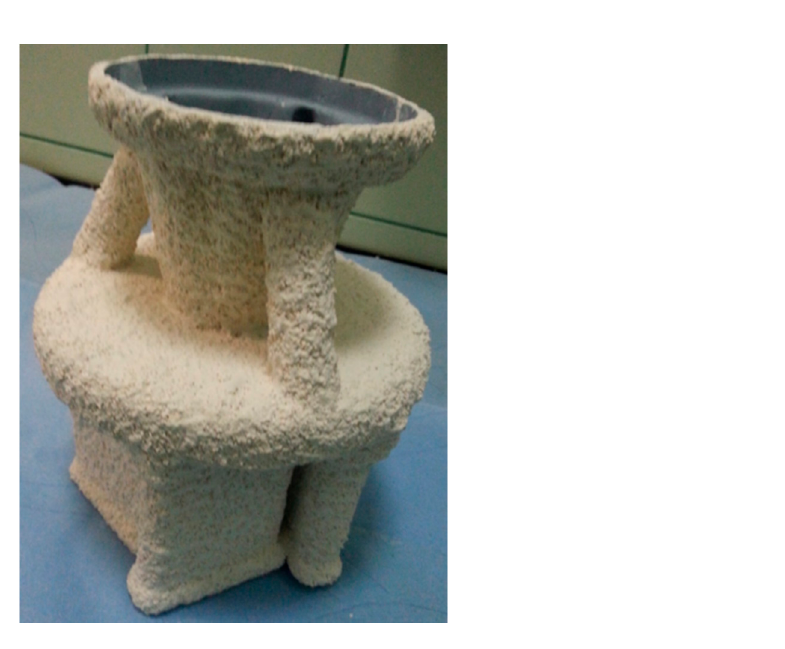
Figure 20. Example of a ZrO 2 ceramic mould obtained with Ludox SK and EHT binders.